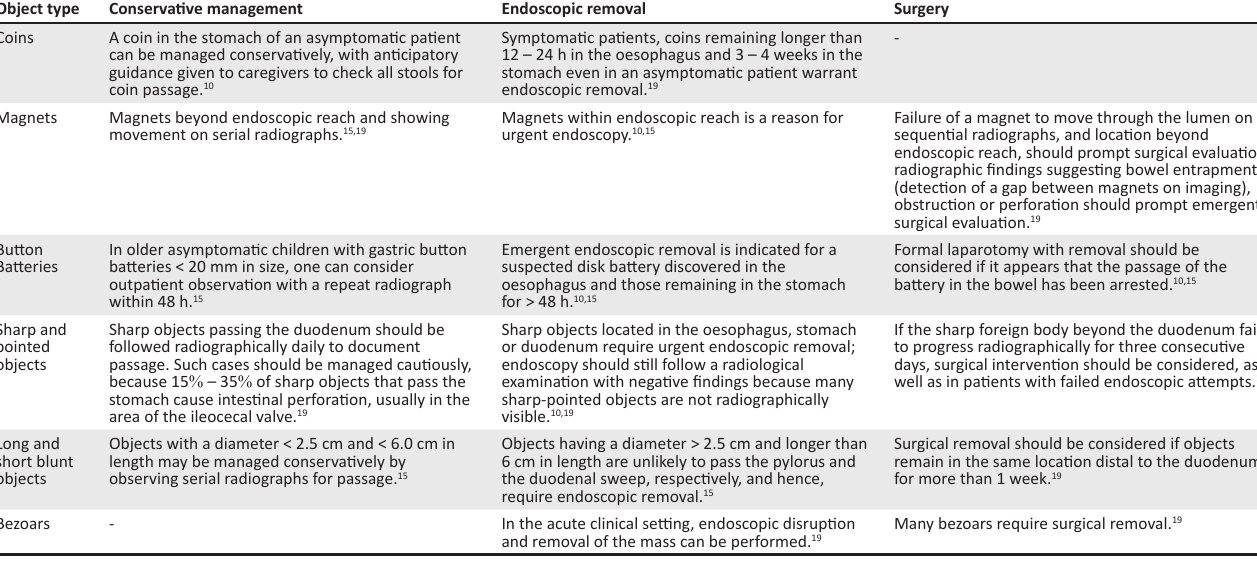
TABLE 1: Indications for ingested foreign body management in the paediatric population by conservative approach, endoscopy or surgery according to literature review. Object type Conservative management